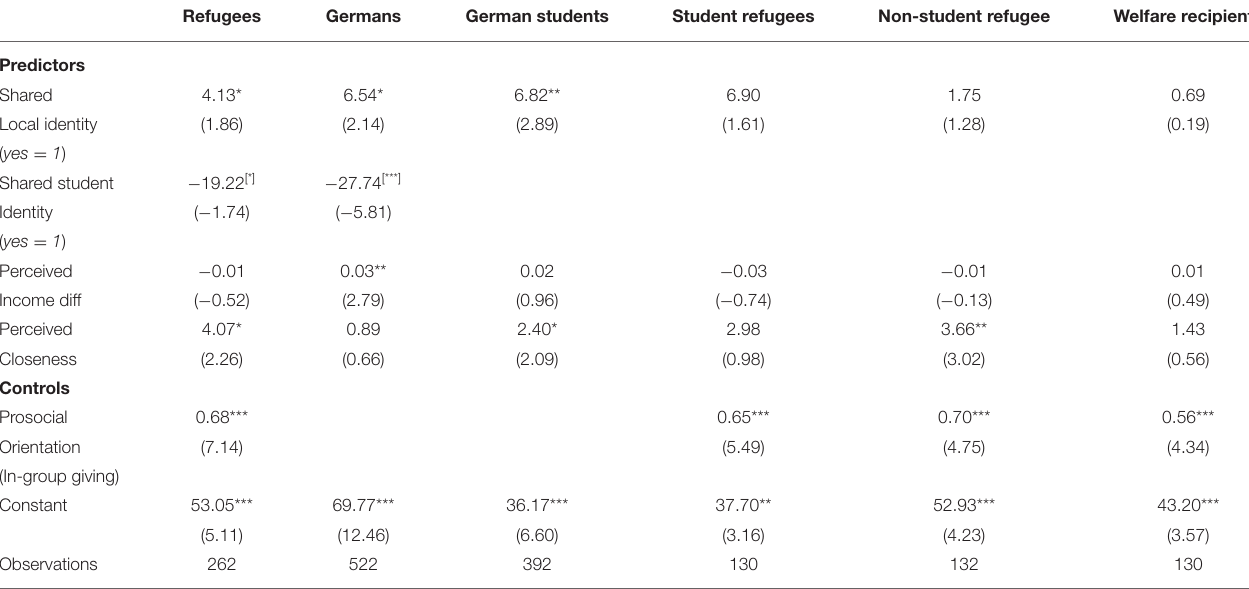
TABLE 2 | Subgroup analyses of altruistic giving for the refugee (student and non-student refugees, column 1) and German (German students and social welfare recipients, column 2) subsample and for each individual receiver group separately (columns 3–6).